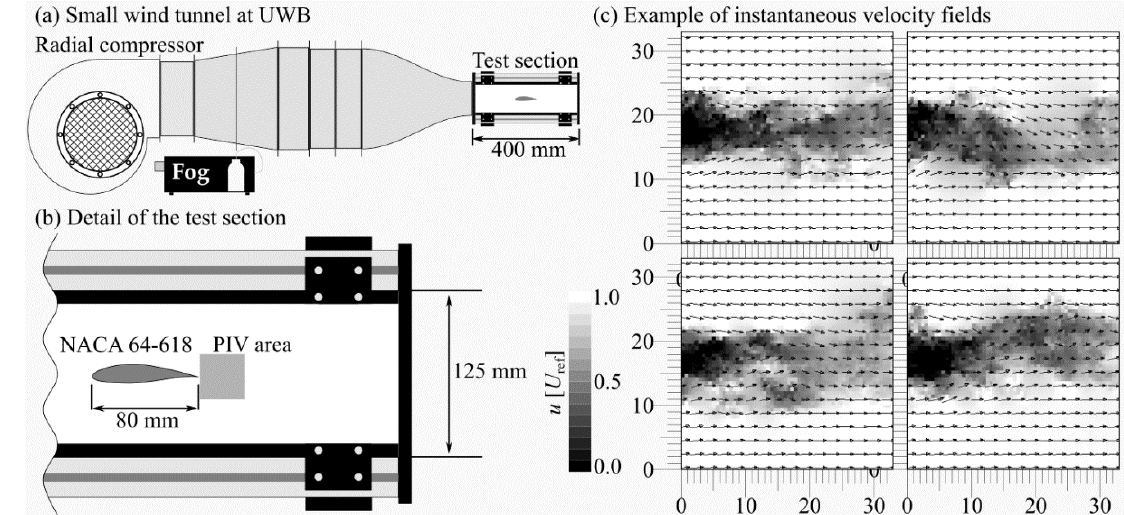
Figure 1. ( a ) Sketch of the “small” open wind tunnel used at the University of West Bohemia in Pilsen. The test section is 400 mm long, it has square cross-section of the side of 125 mm. ( b ) The localization of the measured airfoil of chord is 80 mm within the test section; its maximum thickness is 14.5 mm, thus the blockage ratio is 11.6%. The area studied by PIV is just behind the trailing edge with dimensions of 33 × 33 mm, i.e., 0.4 × 0.4 chord length. The PIV plane is 45 mm from the bottom wall. ( c ) Example of few instantaneous velocity fields. The grayscale corresponds to stream-wise velocity component, U ref , which means the reference velocity measured in empty wind tunnel, for presented data, is equal to 11.5 m/s. Only every fourth velocity vector is shown. The entire ensemble of 1208 snapshots is animated in http://home.zcu.cz/~dudad/Ct300a00ab.gif (40 MB, accessed on 29 July